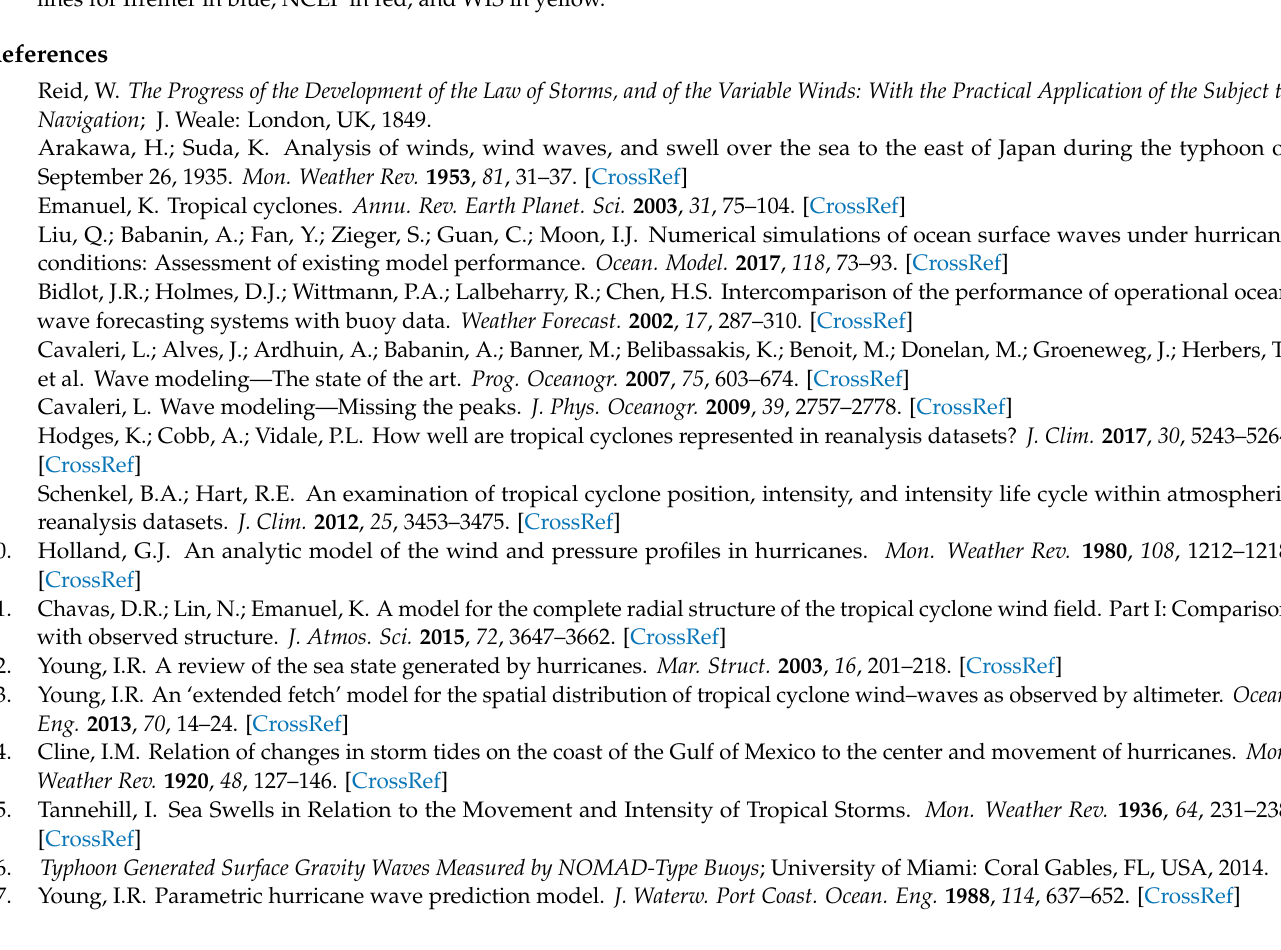
Figure A2. Model errors as a function of observed wave height. Relative bias is shown in solid lines and nrmse in dashed lines for Ifremer in blue, NCEP in red, and WIS in